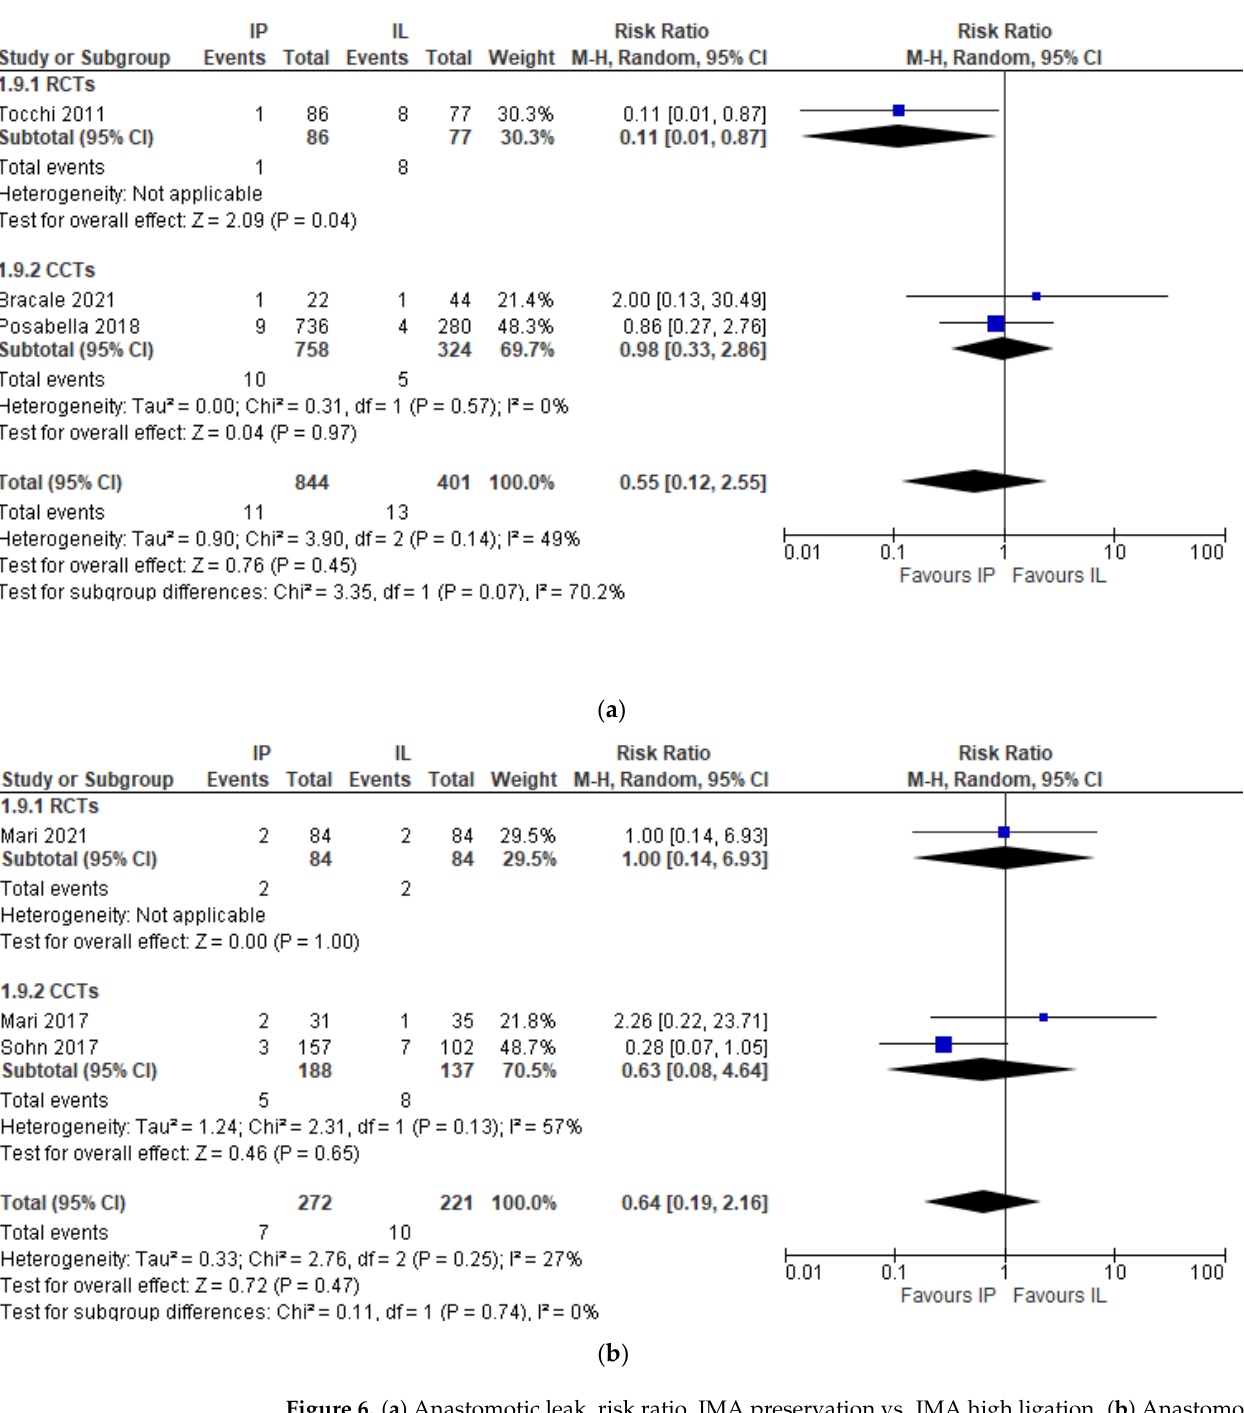
Figure 7. Post-operative rectal bleeding, risk ratio.